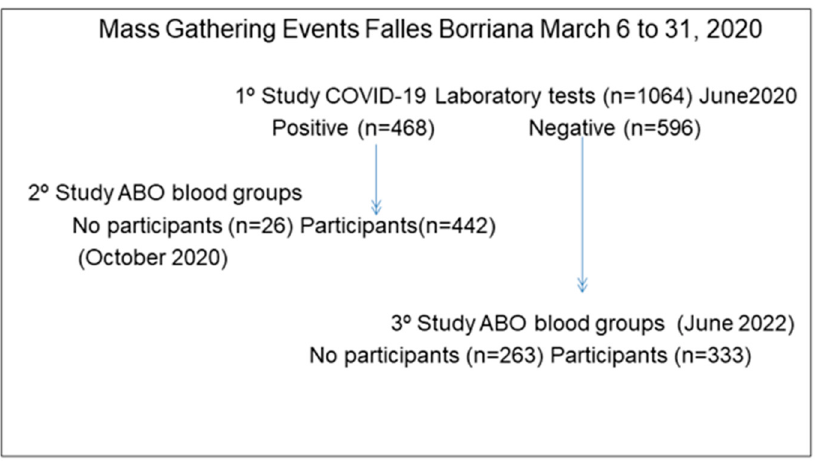
Figure 1. Flow chart of the three studies of COVID-19 and ABO blood groups in the Borriana COVID-19 cohort.